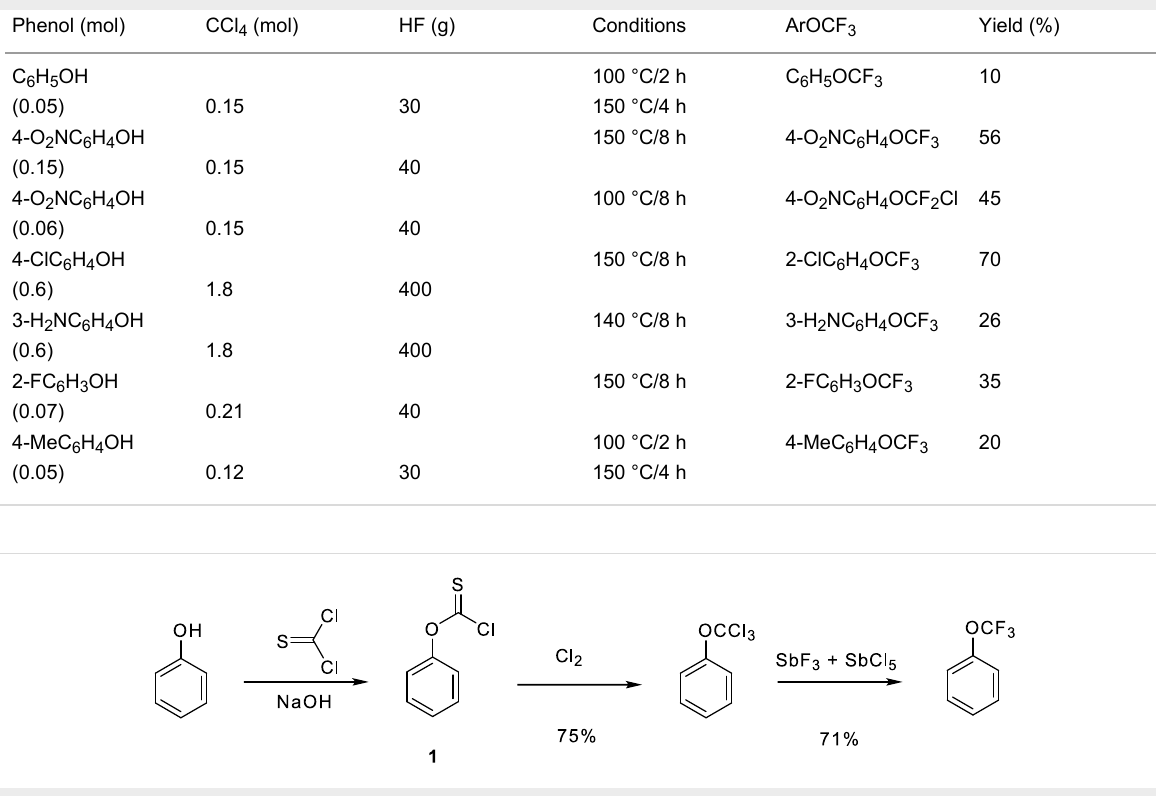
Table 3: Synthesis of ArOCF 3 compounds via an in situ Cl/F exchange.